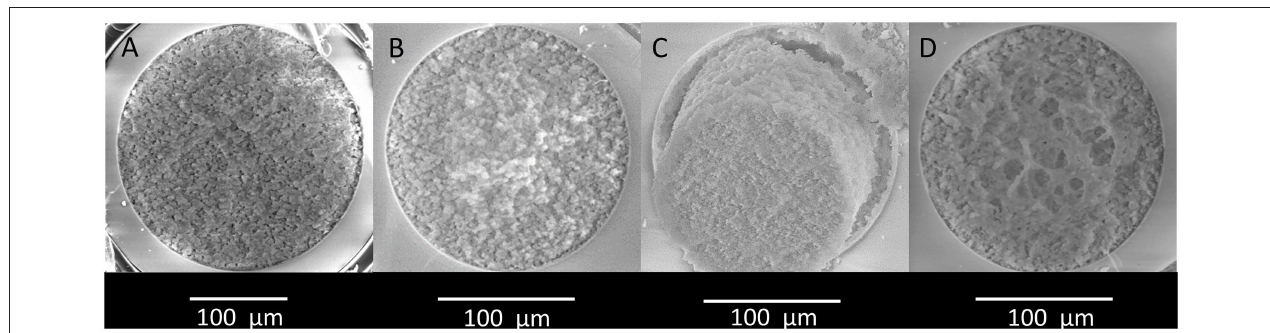
FIGURE 4 | Micrographs of the cross-section of (A) a 250 µ m ID and (B) a 180 µ m ID poly(VDM-co-EDMA) monolith. (C) A 180 µ m ID monolith not attached to the wall, and (D) a 180 µ m ID monolith with large pores. The micrographs were captured by a large field detector (LFD) at 15.0 kV working at a distance of minimum 12mm from the sample in low vacuum with a spot size of